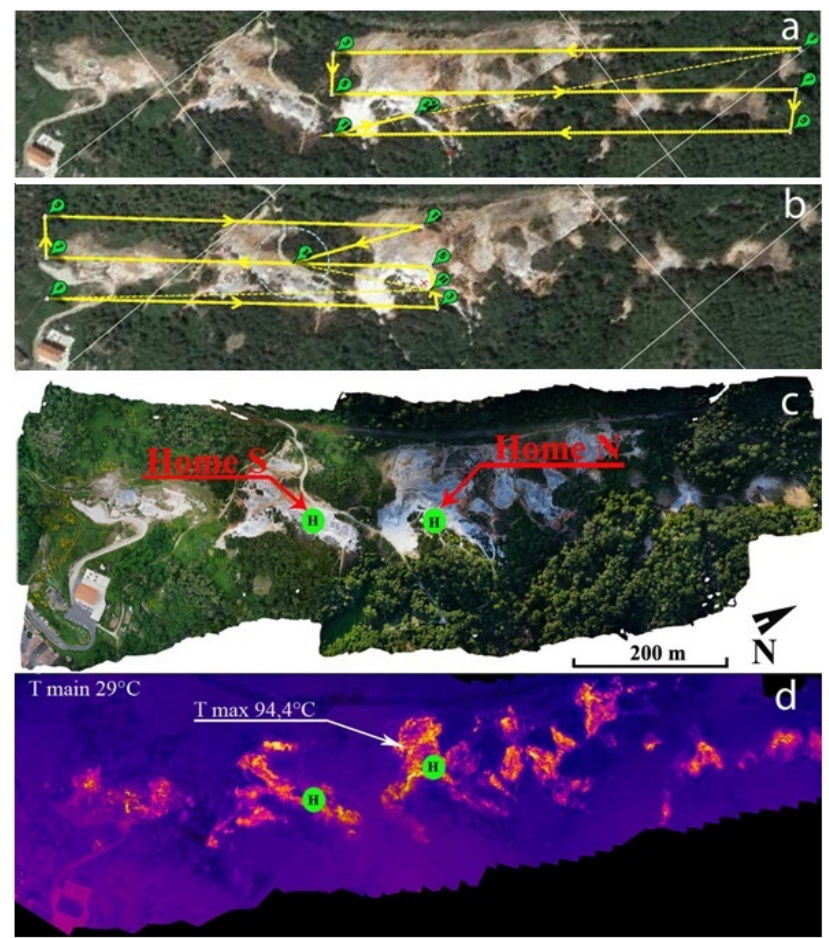
Figure 6. UAV flight of 19 June 2019 on the Parco delle Biancane: ( a ) flight plan for the northern sector; ( b ) flight plane for the southern sector; ( c ) visible mapping; ( d ) thermal mapping. The “Home” (H) indicates the take-off point of the UAV which has a ground elevation of 621 m and 610 m in the northern and southern sector, respectively.